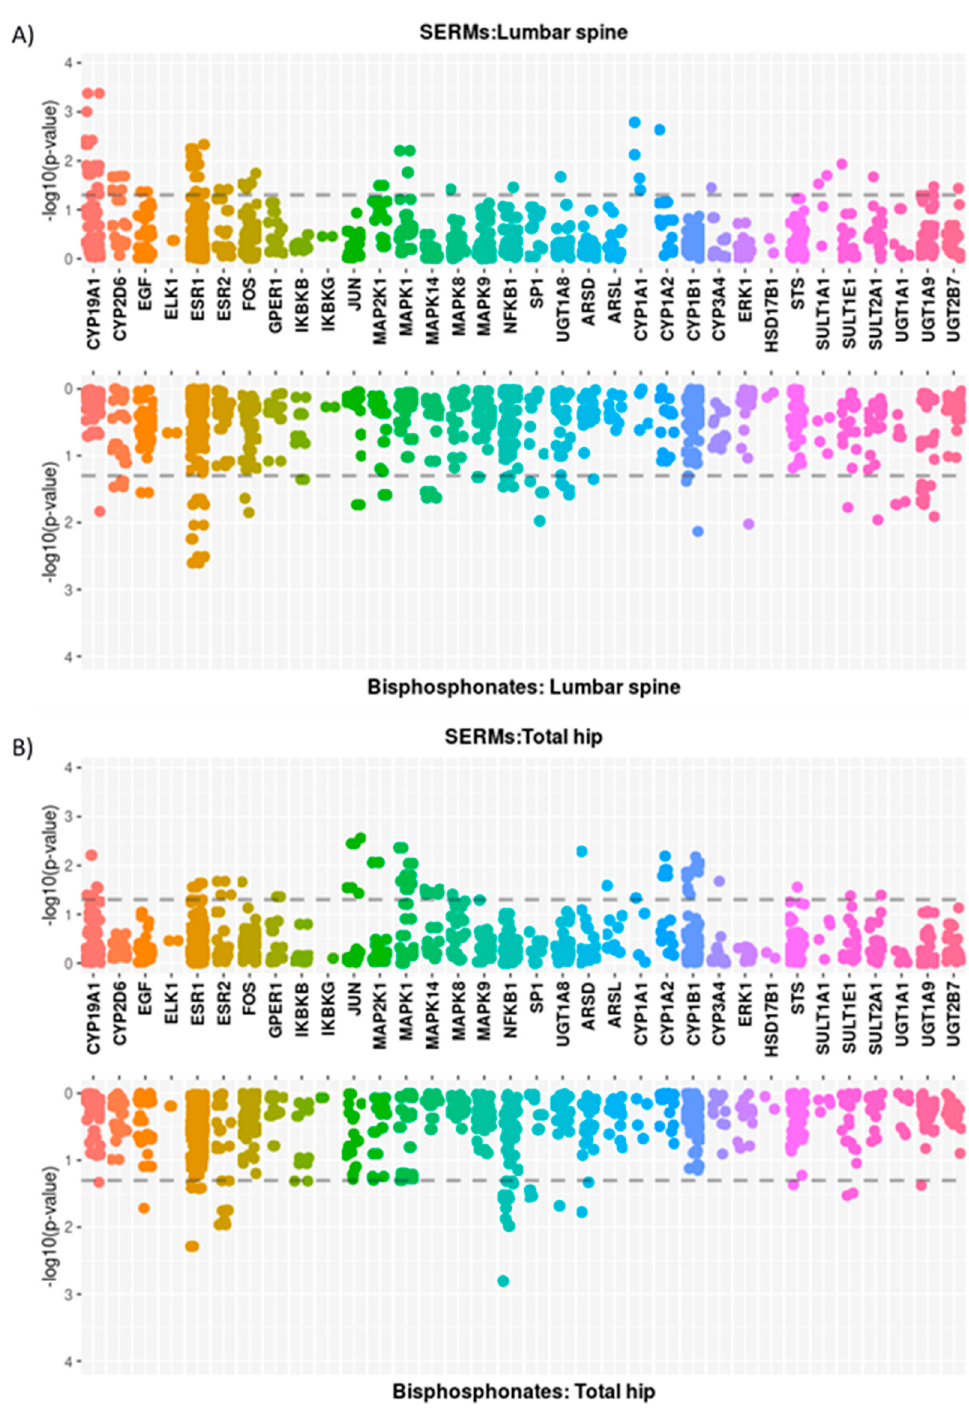
Figure 3. Miami plots showing the p ‐ values of the association between oestrogen pathway SNPs and annual BMD change at the spine ( A ) and the hip ( B ). For both regions, the results of the SERM ‐ treated groups (upward) and BP ‐ treated group (downward) are shown.